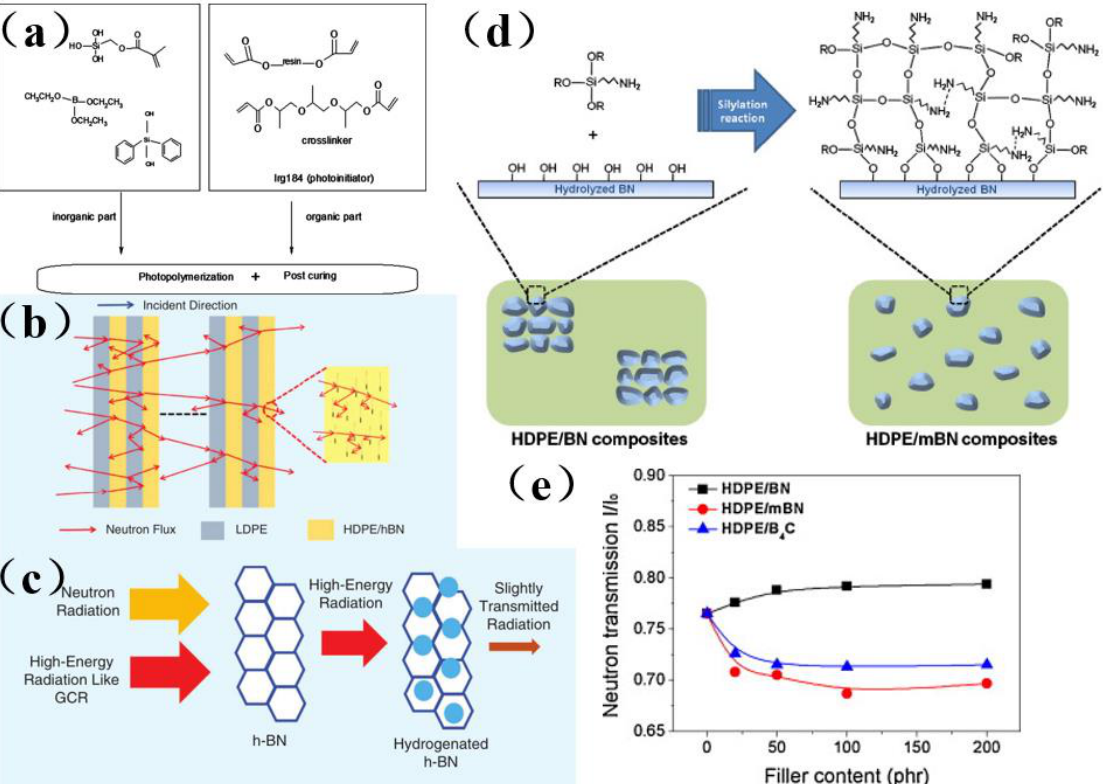
Figure 12. ( a ) Preparation of a hybrid coating containing boron [122]. Copyright 2021, IEEE. ( b ) Schematic diagram of radiation protection effect of hydrogen boron nitride and hydrogenated hydrogen boron nitride [123]. Copyright 2017, Elsevier. ( c ) Multilayer PE/hBN composites and their neutron shielding properties [124]. Copyright 2017, Elsevier. ( d ) Schematic diagram of surface modification of BN with trialkoxysilane [125] Copyright 2014, Elsevier. ( e ) The relationship between neutron transmission coefficient of HDPE/BN, HDPE/mBN and HDPE/B 4 C composites and filler content. d, e. [125] Copyright 2014,